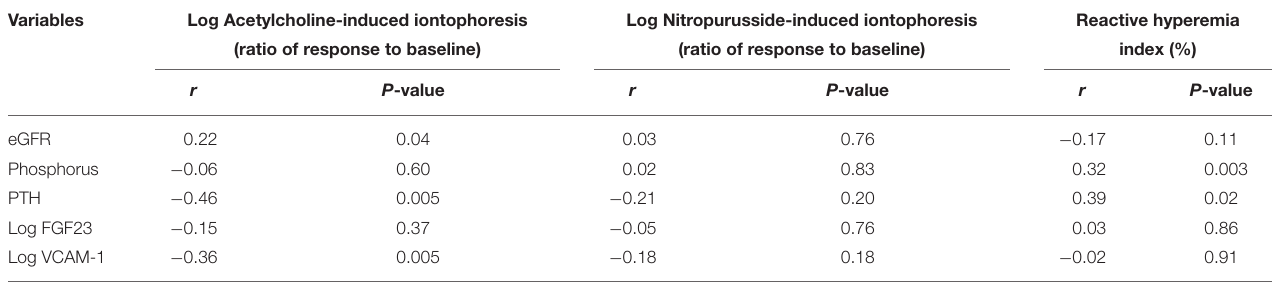
TABLE 3 | Crude association between phosphorus, iPTH, FGF23, VCAM-1 and endothelial function assessments by Pearson correlation. Variables Log Acetylcholine-induced iontophoresis Log Nitropurusside-induced iontophoresis Reactive hyperemia (ratio of response to baseline) (ratio of response to baseline) index (%)